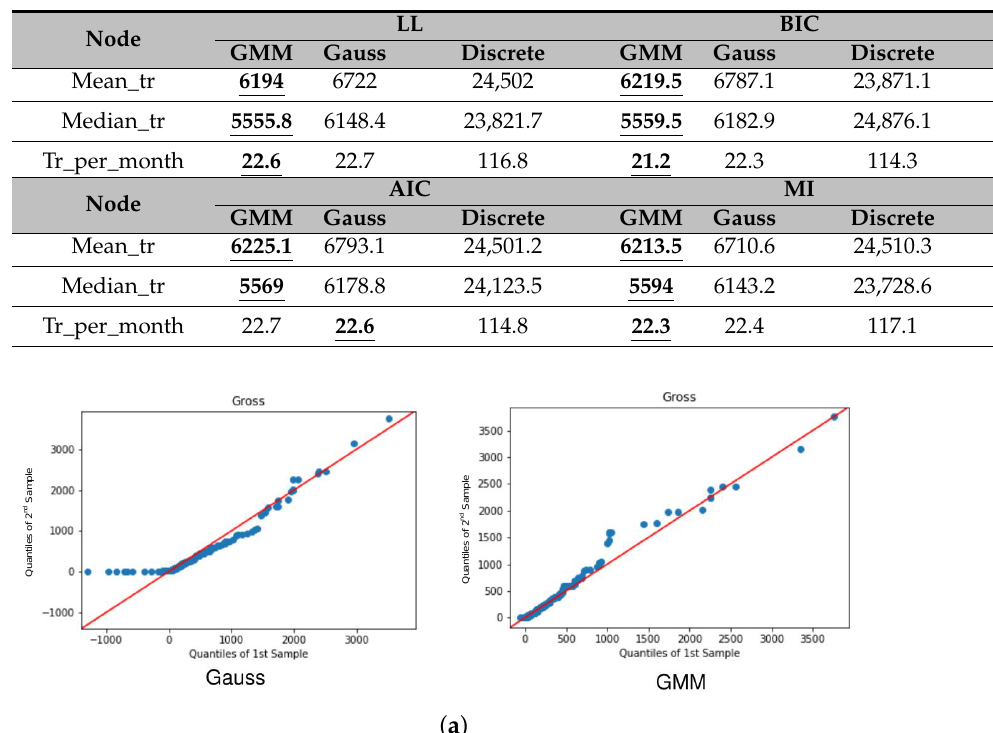
Table 2. RMSE of restoration for continuous nodes with different methods of structural learning (BIC, AIC, LL, MI) and parameters learning methods for bank customers’ data.